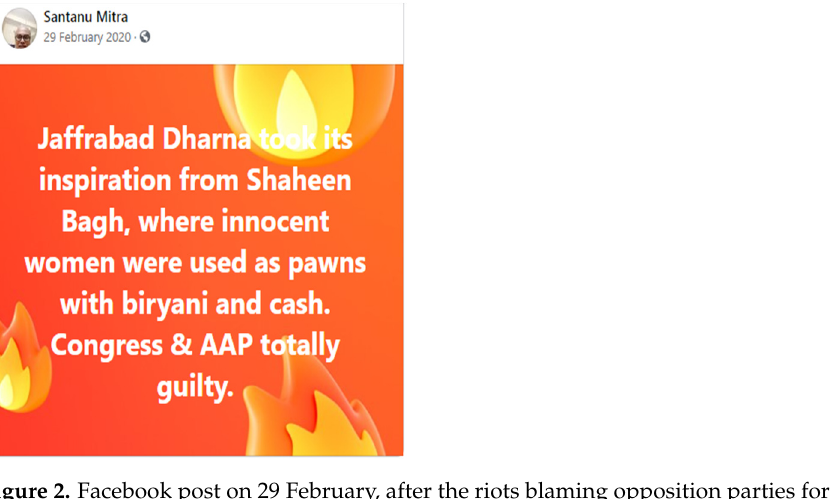
Figure 2. Facebook post on 29 February, after the riots blaming opposition parties for the Jaffrabad protests—which led to violent clashes—as it failed to take action against Shaheen Bagh which was the inspiration for anti-CAA protests.